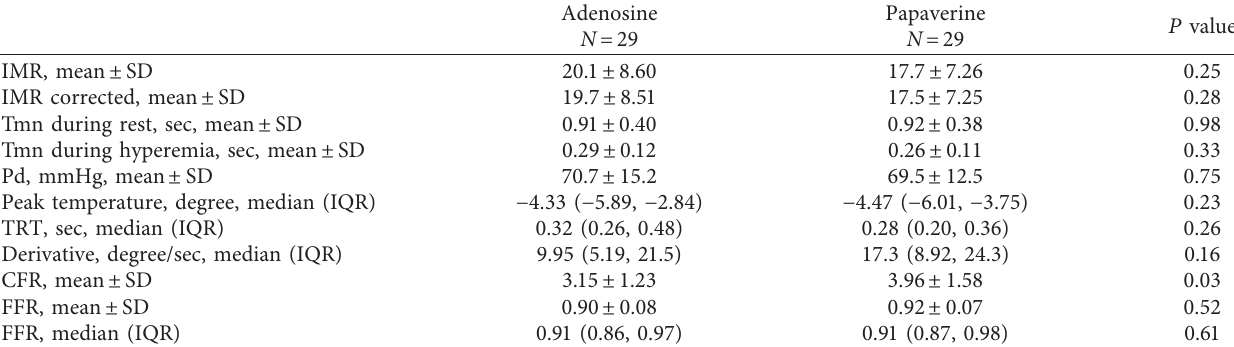
Table 2: Invasive physiologic measurements with adenosine and papaverine.